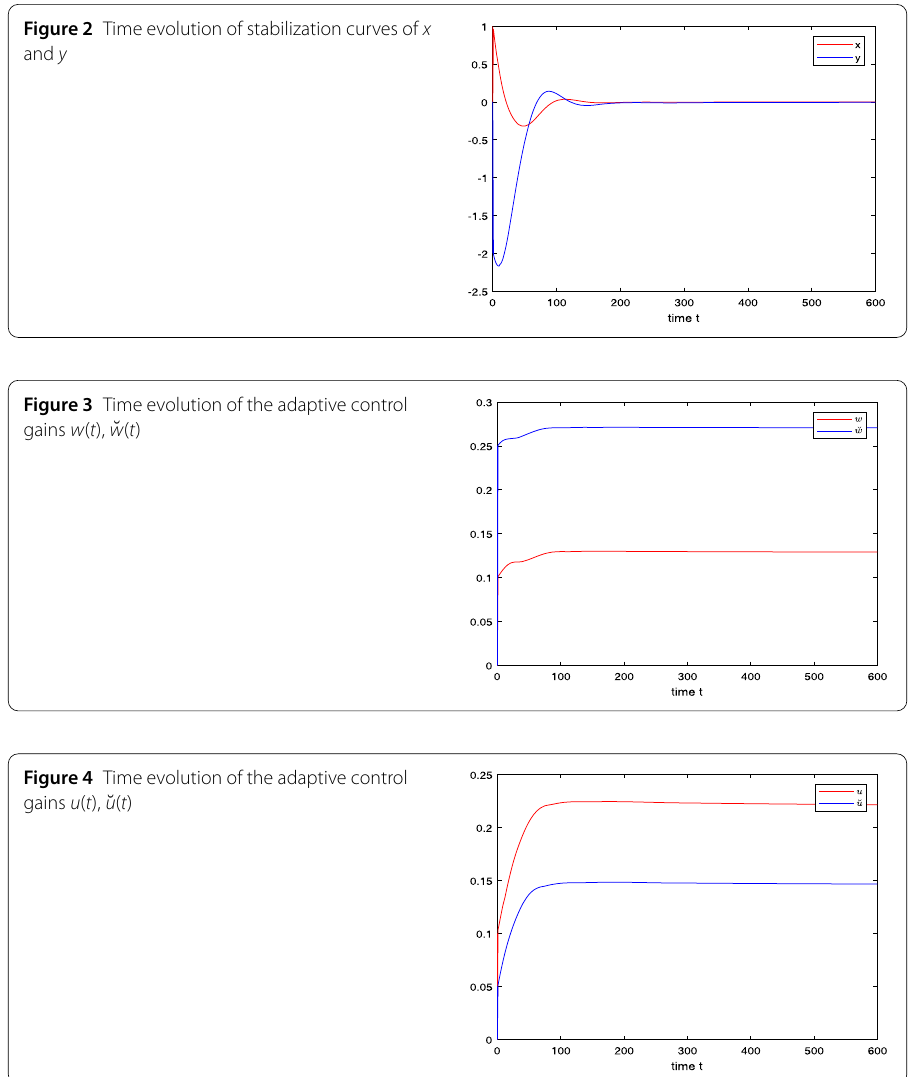
Figure 2 Time evolution of stabilization curves of x and y